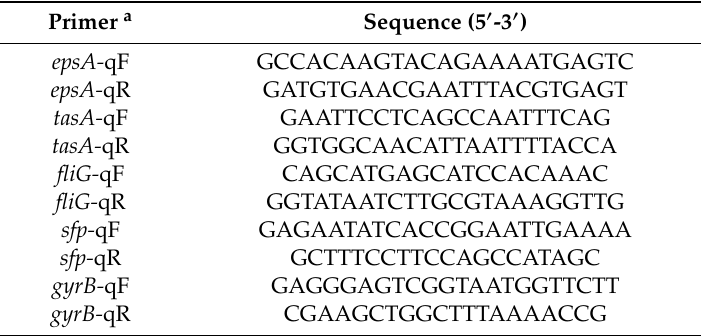
Table 1. The qRT-PCR primer pairs of biofilm-related